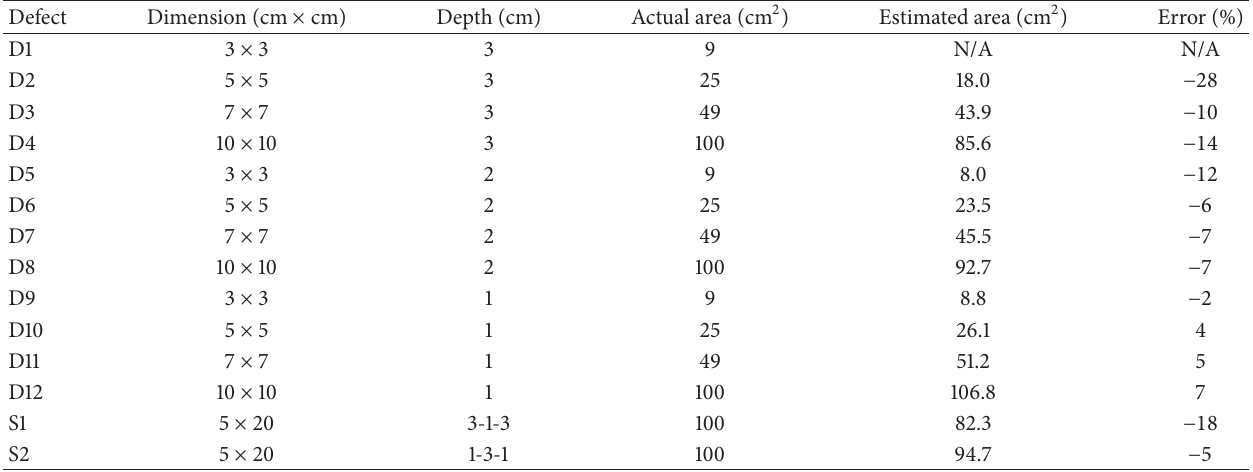
Table 5: Results of detecting the defective area after the 20-minute heating